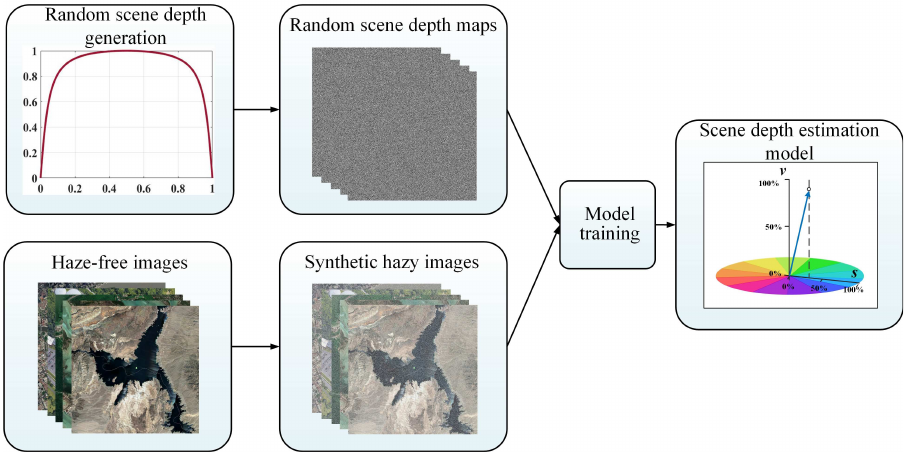
Figure 4. The training process of a linear scene depth model for remote sensing